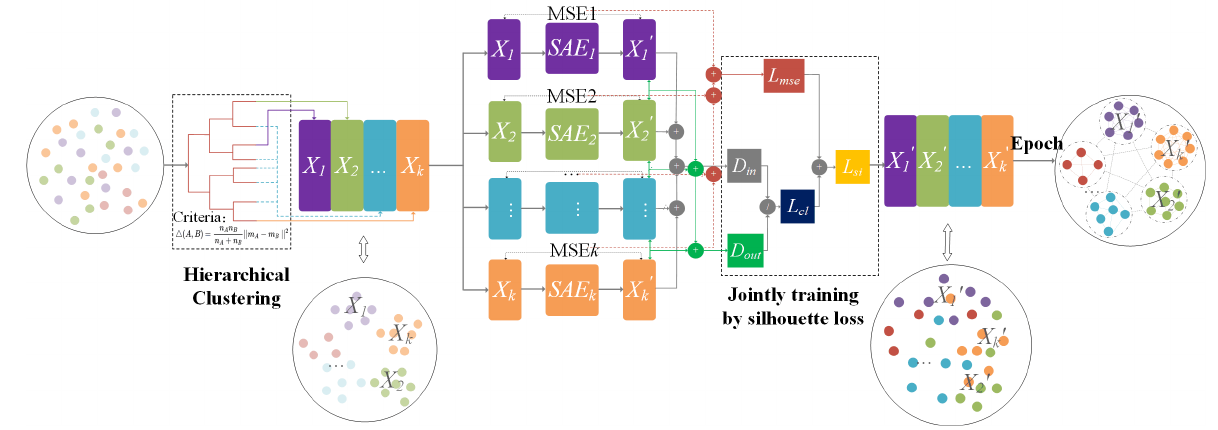
Figure 3. The detection model of